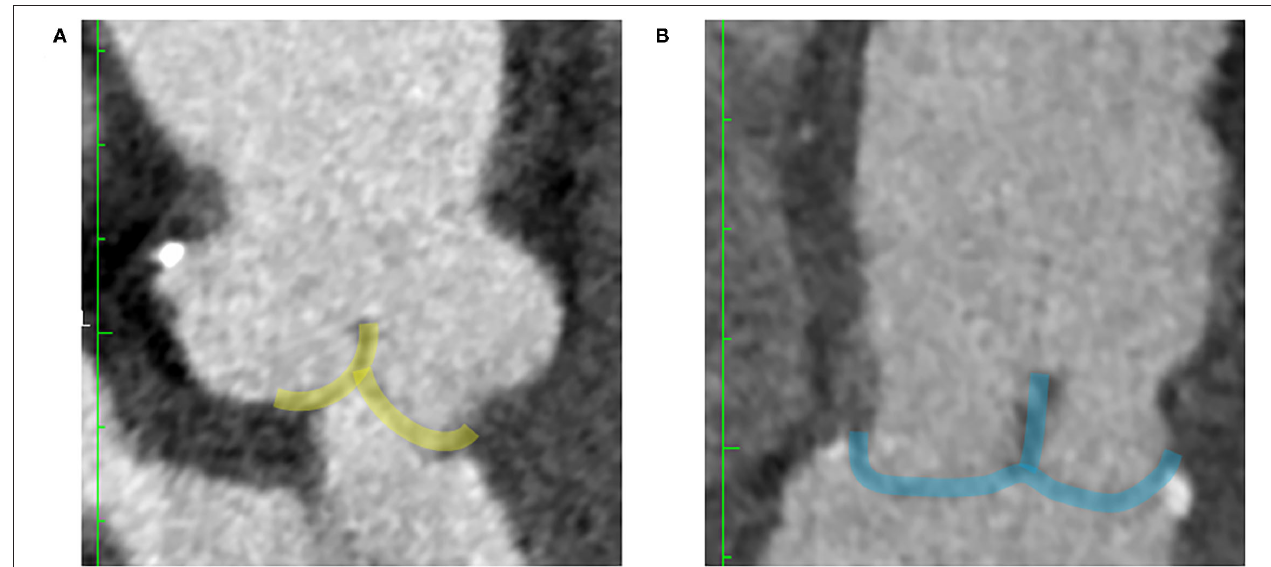
FIGURE 5 | CT features of post-repair valve coaptations. The shaded green area delineated the post-repair coaptation without leaflet billowing in a reversed Y form (A) . The shaded blue area delineated the post-repair coaptation with leaflet billowing in a reversed T form (B) .